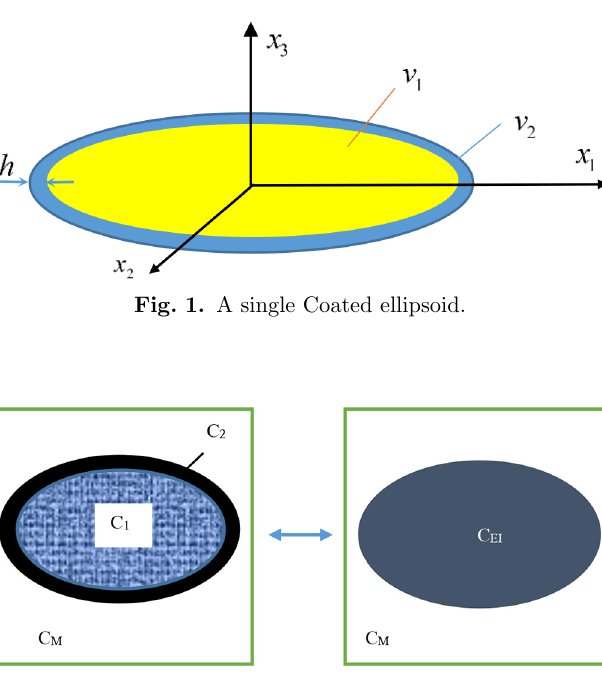
Fig. 2. Unit cell: Coated ellipse (left), equivalent inclusion (right).